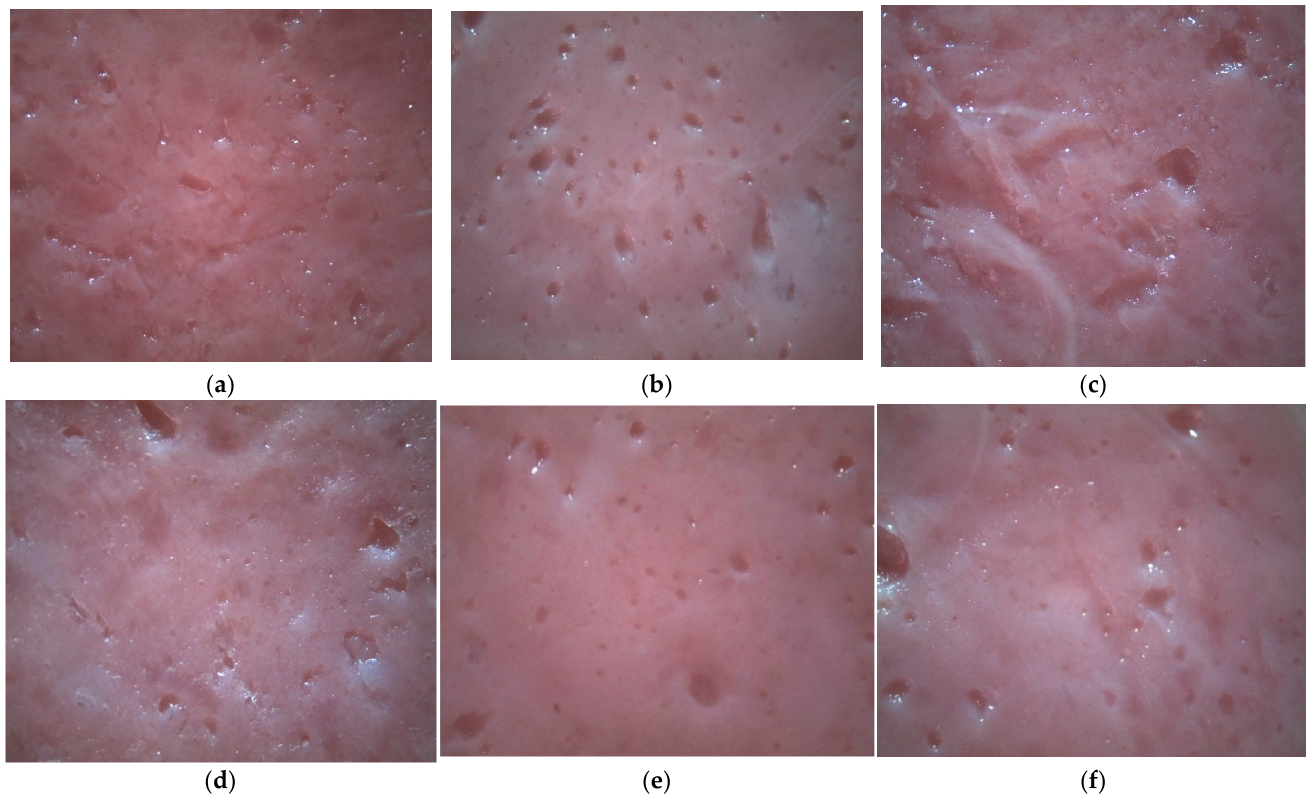
Figure 2. Stereomicroscopic image of beef compositions with di ff erent additions. B—control sam ‐ ple (no additions); BCh—beef emulsion with chickpea flour; BL—beef emulsion with lupine concentrate; BSPI—beef emulsion with soy protein isolate; BCs—beef emulsion with sodium caseinate; BSt—beef emulsion with starch. ( a ) Stereomicroscopic image of the B gel; ( b ) Stereomicroscopic image of the BCh gel; ( c ) Stereomicroscopic image of the BL gel; ( d ) Stereomicroscopic image of the BSPI gel; ( e ) Stereomicroscopic image of the BCs gel; ( f ) Stereomicroscopic image of the BSt gel.